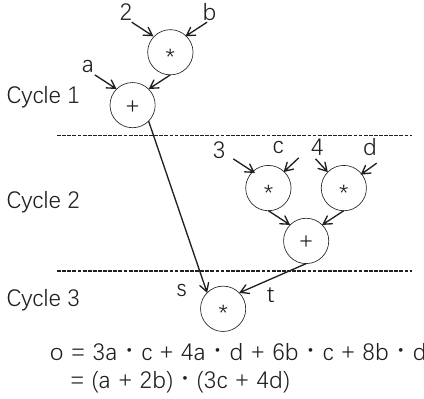
Figure 8. A possible scheduling